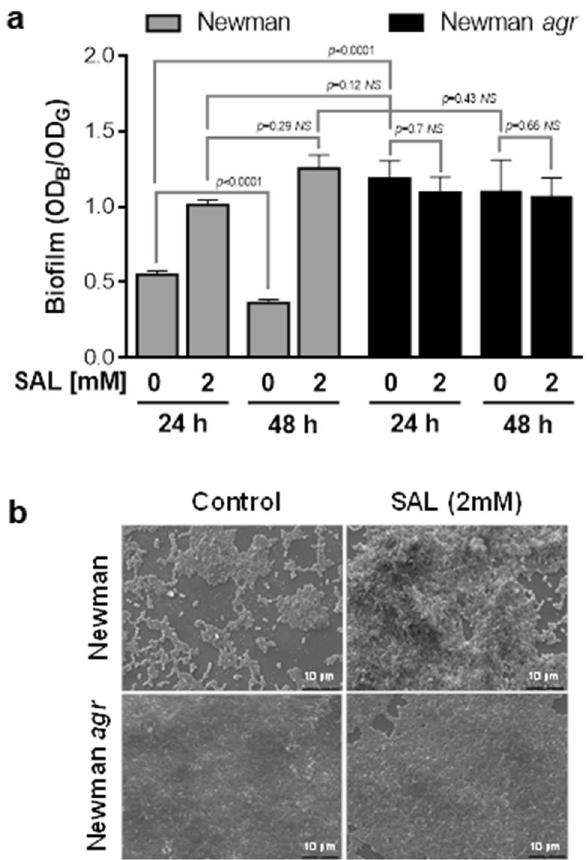
Figure 1. SAL prevents S. aureus biofilm dispersion. ( a ) Biofilm formation by the Newman strain or Newman agr mutant exposed to 2 mM of SAL measured after 24 and 48 h of static incubation at 37 °C. Each bar represents the mean ± SEM of 8 wells from 4 independent experiments. Biofilm formation values correspond to the OD 595 of crystal violet (OD B ) measured relative to the final culture density (OD G ) after 24 or 48 h incubation. Comparison of Newman treated with SAL and Newman agr treated with SAL at both time points showed no significant differences. Statistical analysis was performed with the Mann–Whitney test. ( b ) Scanning electron microscopy (SEM) representative images of Newman and Newman agr biofilms grown statically for 24 h at 37 °C in the presence or absence of 2 mM of SAL. The black bars correspond to 10 μm. The magnification is 2000×.